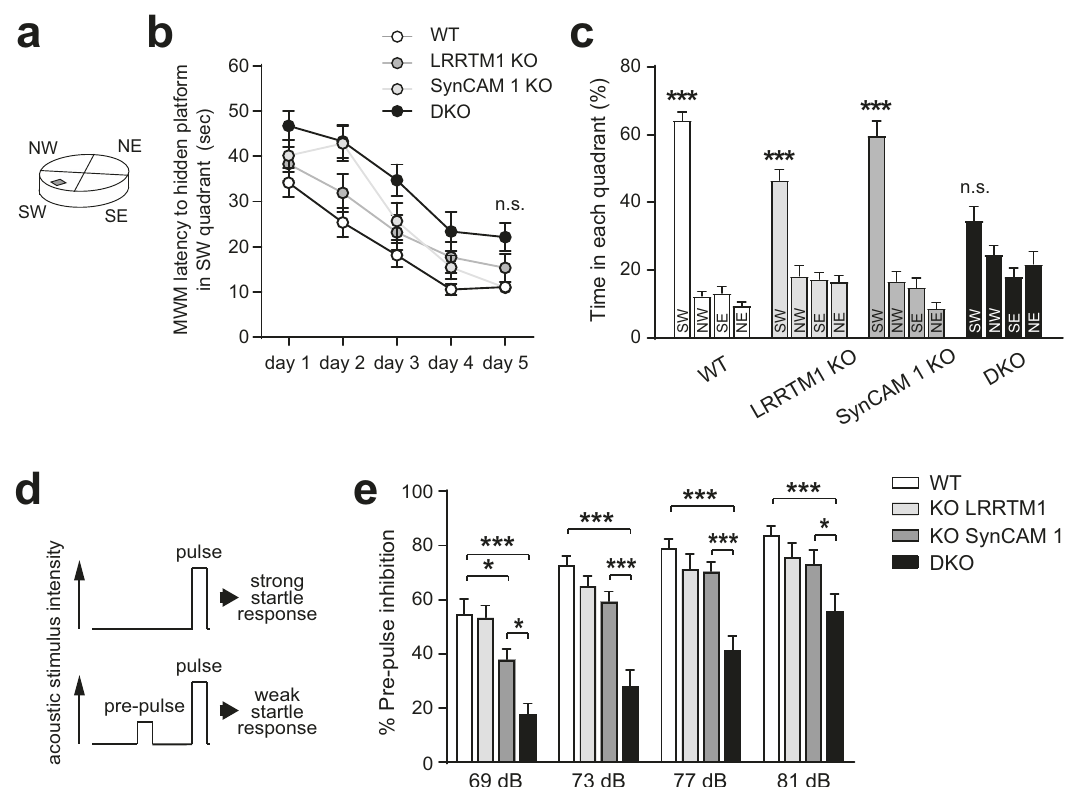
Fig. 7 | Combined loss of LRRTM1 and SynCAM 1 impairs cognition-relevant behaviors.a SpatialmemorywastestedintheMorriswatermazedividedintofour quadrants,withtheSWquadrantcontainingtheescapeplatform. b Latencytimeto the target the SWquadrantinthe Morriswatermaze,ameasureof spatialmemory SynCAM 1 KO, 12 DKO mice). c Impaired memory processing in DKO mice. After Morris water maze training, time spent in the target SW quadrant vs. other quad- rants was measured in a probe trial. Unlike WT and single KO mice, DKO mice exhibit no learned preference. (Two-way ANOVA with Bonferroni test for multiple